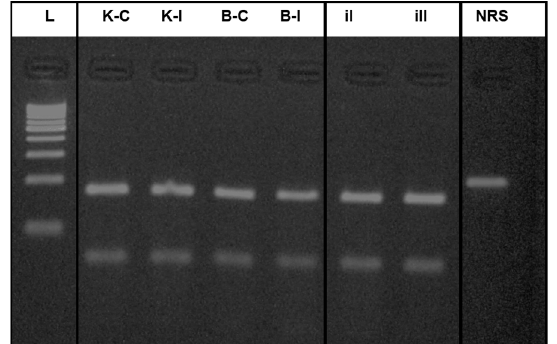
Figure 4. Restriction digestion of sequenced selected TRIM Cassandra fingerprints of common flax varieties Kyivskyi and Bethune grown in the remediated and radio-contaminated field conditions of Chernobyl. L—ladder (100 bp; Thermo Scientific); K-C: Kyivskyi control; K-I: Kyivskyi irradiated; B-C: Bethune control; B-I: Bethune irradiated; iI—inserted amplicon I; iII—inserted amplicon II; NRS—no restriction sample. A 1000 bp ladder was used (Fermentas).